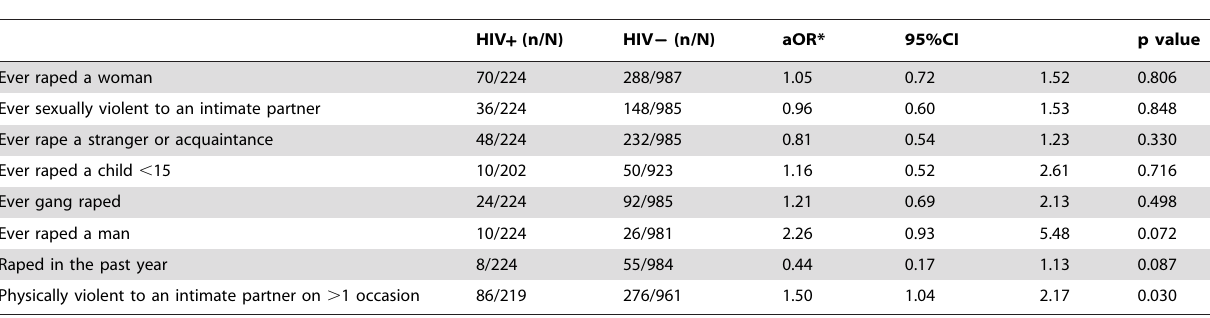
Table 3. Association between perpetration of violence and HIV sero-positivity.